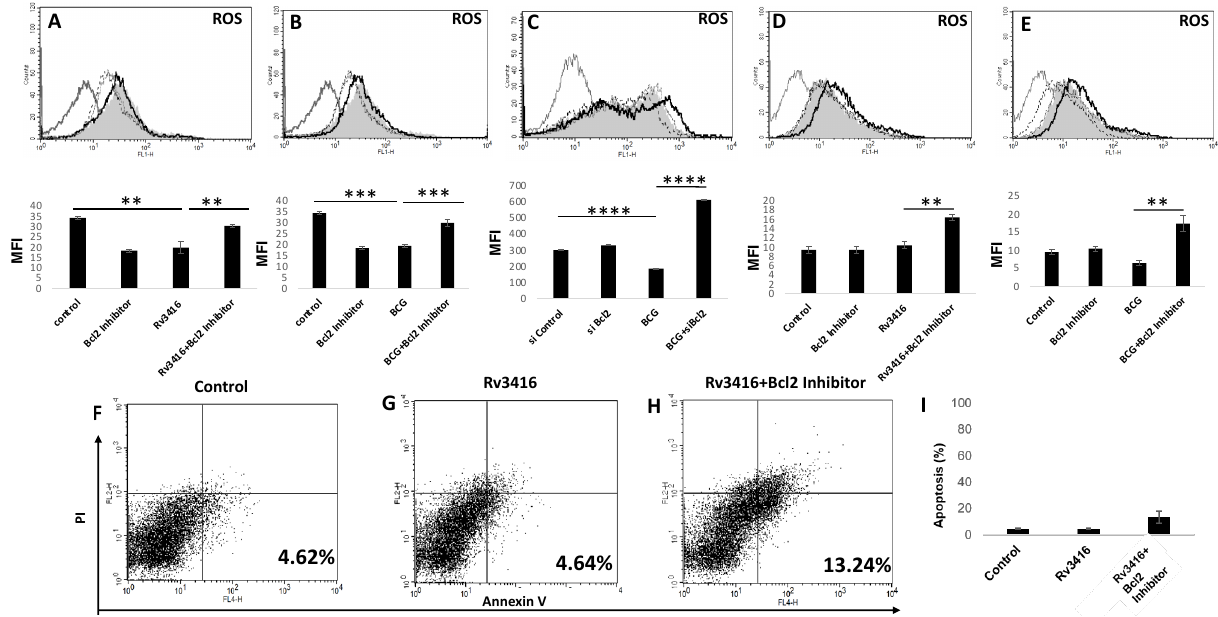
Figure 5: Inhibiting Bcl2 in Rv3416 stimulated BMDCs and PBMCs induces oxidative burst. Either BMDCs (Panel A-C) or PBMCs (Panel D&E) were incubated with 10 μM Bcl2 Inhibitor for 1h followed by stimulation with 15 μg/ml Rv3416 for 1h. For Panel C BMDCs were transfected with either Control siRNAs (Panel C) or Bcl2 specific siRNAs prior to Rv3416 stimulation. ROS levels were monitored by flow cytometry. Shaded histogram in all the Panels represents unstimulated cells. Thin Grey line in Panels A,B,D&E represent Bcl2 Inhibitor treated cells. Thin Grey line in Panel C represents Control siRNA treated cells. Dotted line in Panels A&D represents Rv3416 treated cells. Dotted line in Panels B,C&E represents BCG infected cells. Thick Black line in Panels A&D represents Rv3416+Bcl2 inhibitor treated cells. Thick Black line in Panels B&E represents BCG+Bcl2 inhibitor treated cells. Thick Black line in Panels C represents BCG+siBcl2 treated cells. Data shows a representative image of two independent experiments. Bar charts below each histogram represents Mean Fluorescence Intensity of the groups as a mean of two independent experiments. For Panel A, Control and Rv3416 is P<0.01, between groups Rv3416 and Rv3416+Bcl2 Inhibitor is P<0.01. For Panel B, Control and BCG is P<0.001, between BCG and BCG+Bcl2 Inhibitor is P<0.01. For Panel C, siControl and BCG is P<0.0001, BCG and BCG+siBcl2 is P<0.0001. For Panel D, P value between groups Rv3416 and Rv3416+Bcl2 Inhibitor is P<0.01. For Panel